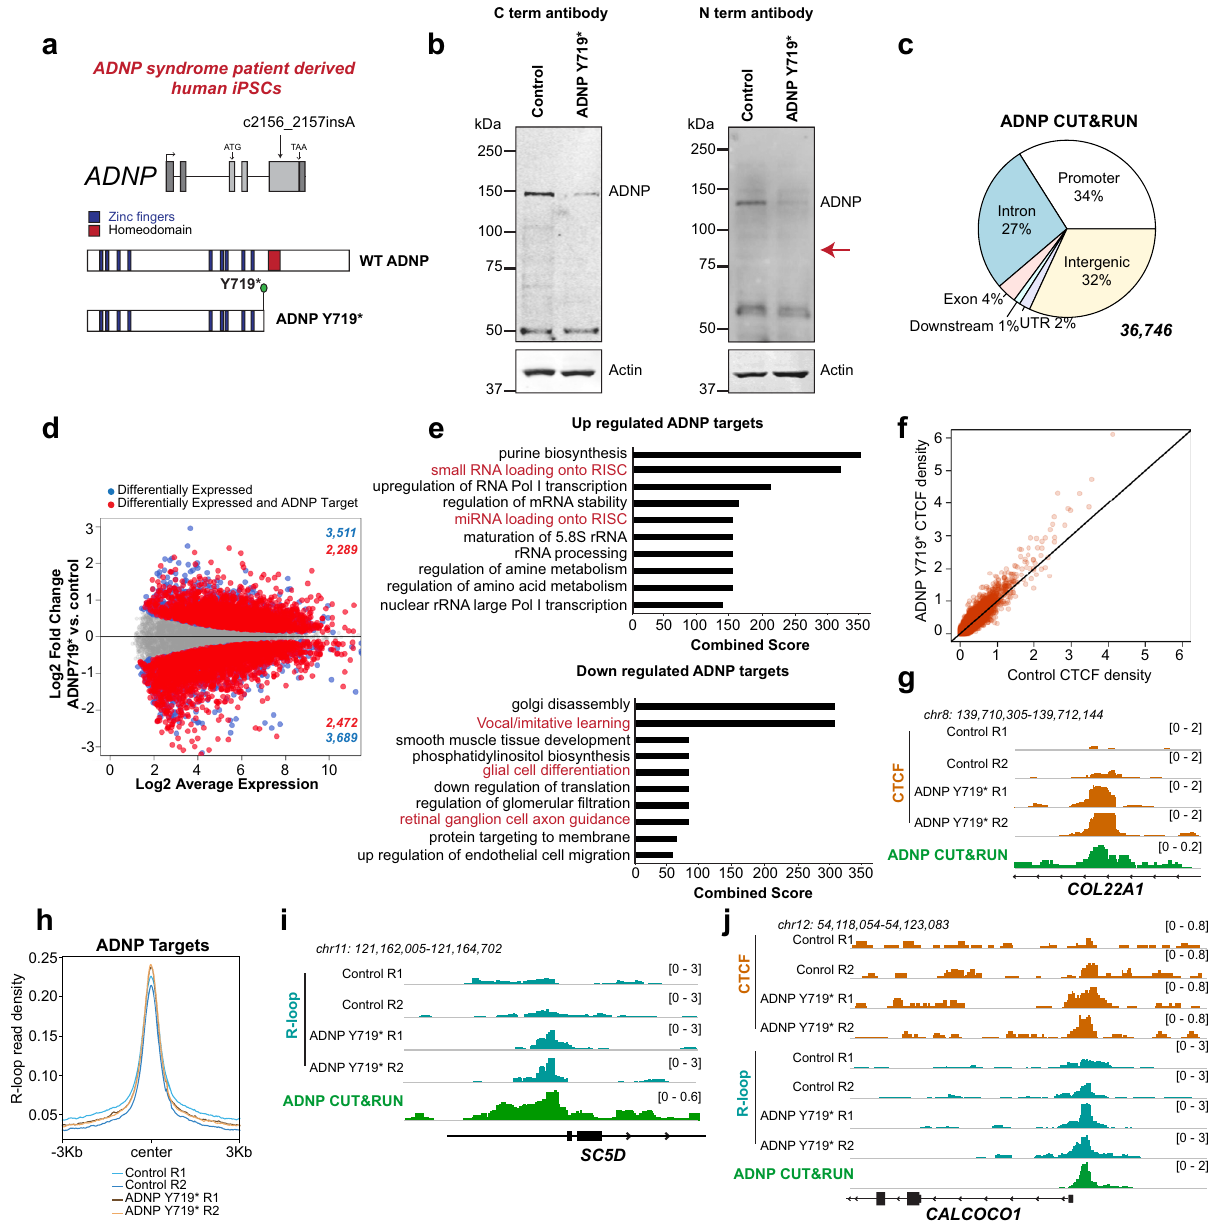
Fig. 7 Patient-derived ADNP Y719* hiPSCs display R-loop accumulation and CTCF increase at ADNP targets. a Schematic of the human ADNP gene showing exons and location of ADNP mutation relative to the cDNA sequence (top). Zinc fi ngers (blue) and homeodomain (red) are present in WT ADNP protein, while ADNP Y719* lacks the homeodomain (bottom). b Western blot for ADNP and Actin in control and ADNP Y719* hiPSCs. ADNP was detected using both C- and N-terminus recognizing ADNP antibodies as indicated. c Pie chart displaying distribution of 36,746 hiPSC ADNP peaks across genomic features. d MA plot of RNA-Seq expression for 13,057 genes between control and ADNP Y719* hiPSCs. Blue dots indicate differentially expressed genes (adjusted p -value < = 0.05; p -values computed by edgeR with Benjamini – Hochberg adjustment for multiple comparisons). Red dots indicate differentially expressed genes with an ADNP CUT&RUN peak within 3 kb of the gene body. e Top 10 most signi fi cantly enriched processes (obtained from Enrichr) in differentially expressed ADNP targets (red dots in d ) that are up- or downregulated in ADNP Y719*. Neurologically relevant processes are shown in red. f Scatterplot of CTCF signal (RPM) in control and ADNP Y719* hiPSCs across 36,746 ADNP CUT&RUN peaks called in control hiPSCs. g Genome browser view of the COL22A1 gene showing CTCF CUT&RUN signal (RPM) in control and ADNP Y719* hiPSCs and ADNP CUT&RUN signal (RPM) in control hiPSCs. h Signal plot of normalized MapR signal in control and ADNP Y719* hiPSCs over 36,746 ADNP CUT&RUN peaks called in control hiPSCs. i Genome browser view of the SC5D gene showing MapR signal (RPM) in control and ADNP Y719* hiPSCs and ADNP CUT&RUN signal (RPM) in control. j Genome browser view of the CALCOCO1 gene showing CTCF CUT&RUN and MapR signal (RPM) in control and ADNP Y719* hiPSCs and ADNP CUT&RUN signal (RPM) in control. Source data underlying ( b ) are provided as a Source data fi